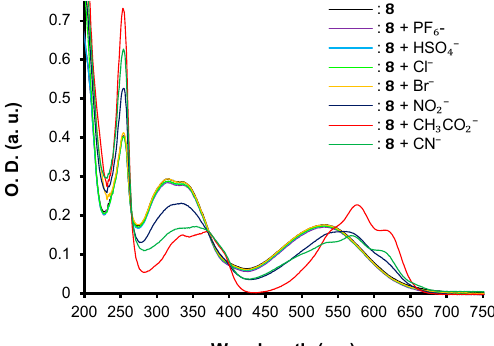
Figure 4. UV–vis spectra for compounds 7 in acetonitrile at [C] = ca 1.40 × 10 − 5 M in presence of 1 equivalent of PF 6 − , HSO 4 − , Cl − , Br − , NO 2 − , CH 3 CO 2 − , and CN − anions as tetrabutylammonium salts in CH 3 CN.